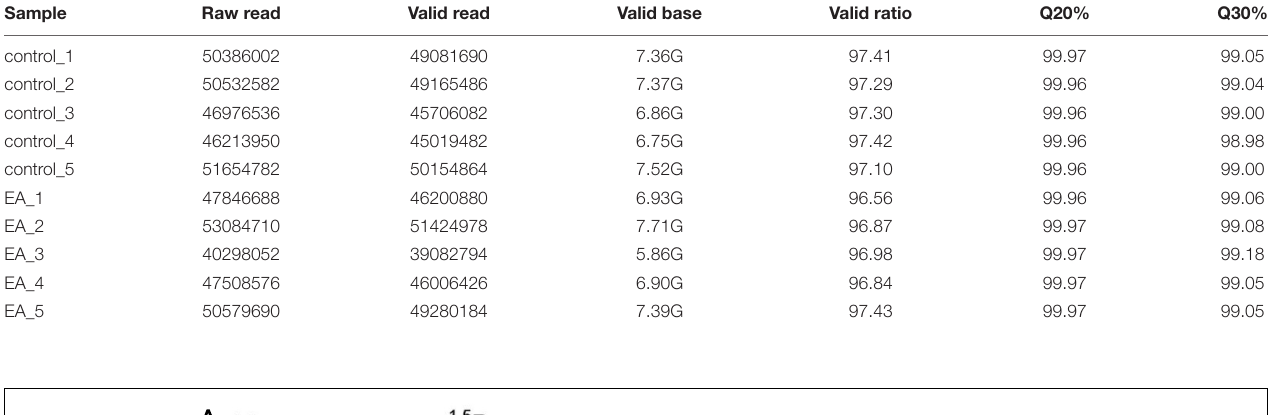
TABLE 2 | The information of raw reads and valid mapping ratio for electroacupuncture and control groups in RNA-Seq. Sample